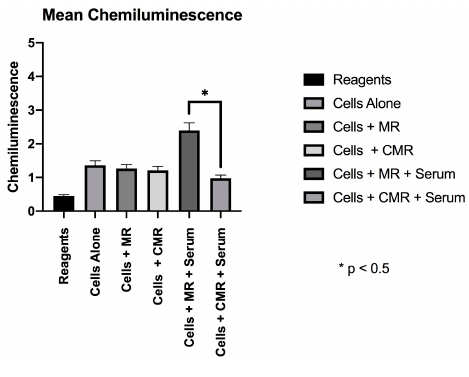
Figure 1. Active chemiluminescence.